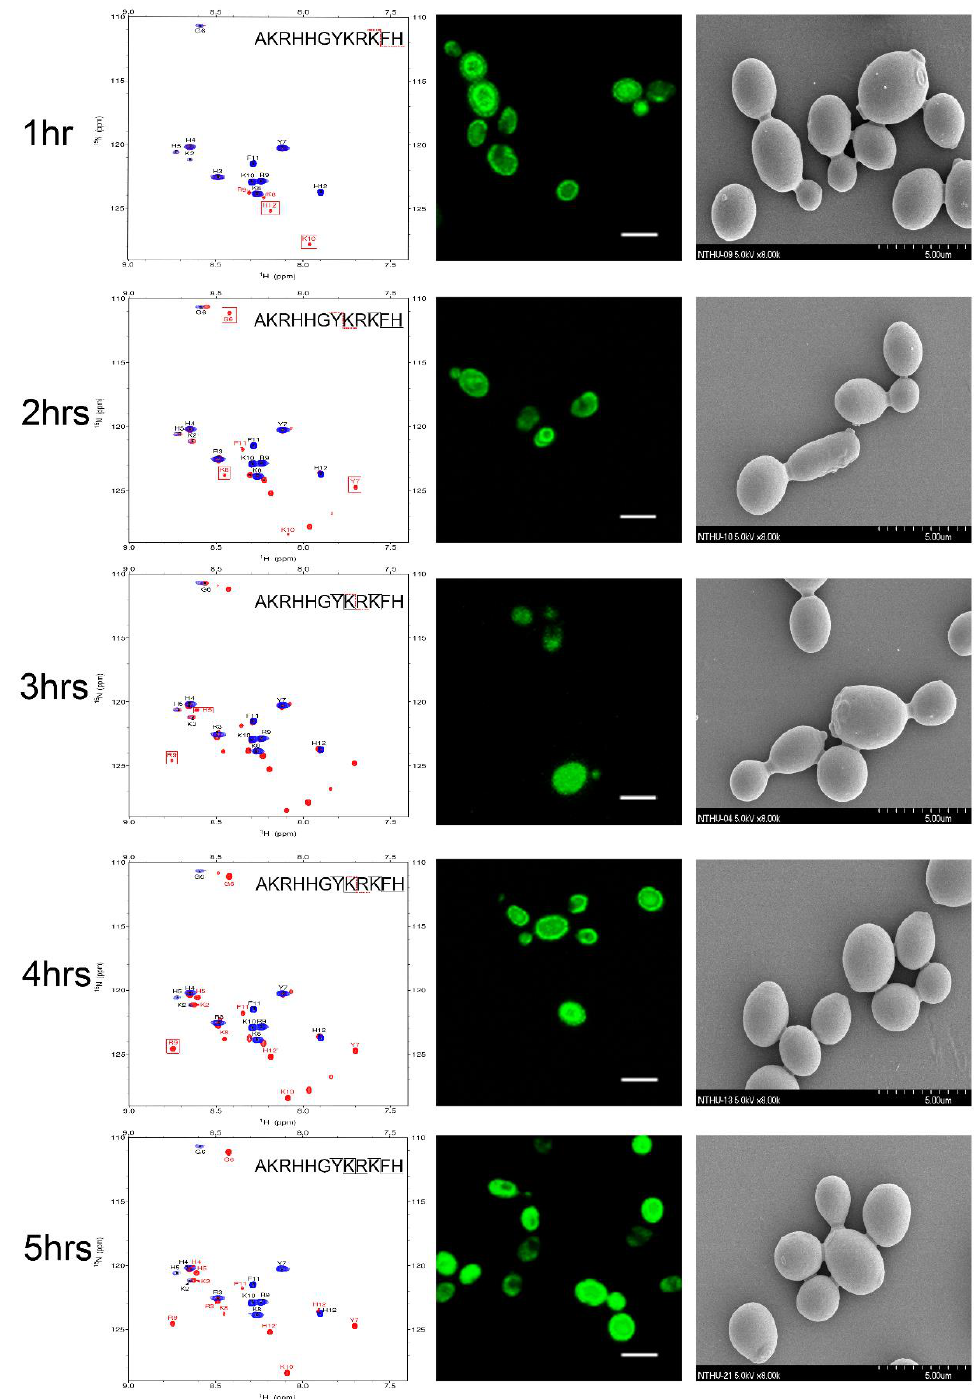
Figure 4. Time-course analysis of 0.25 mM P-113 cleavage following interaction with 10 7 CFU/mL of C. albicans by HSQC spectroscopy (left panels), confocal laser microscopy (middle panels), and scanning electron microscopy (right panels). The bar corresponds to 5 μm. An overlay of 1 H- 1 5N HSQC spectra for 0.25 mM of P-113 in SD broth only (blue) and broth with C. albicans at 301 K at different time points (red) is shown. Perturbations of chemical shifts were observed over 5 h of incubation with C. albicans cells. Cell morphology did not change over the 5 h incubation period.